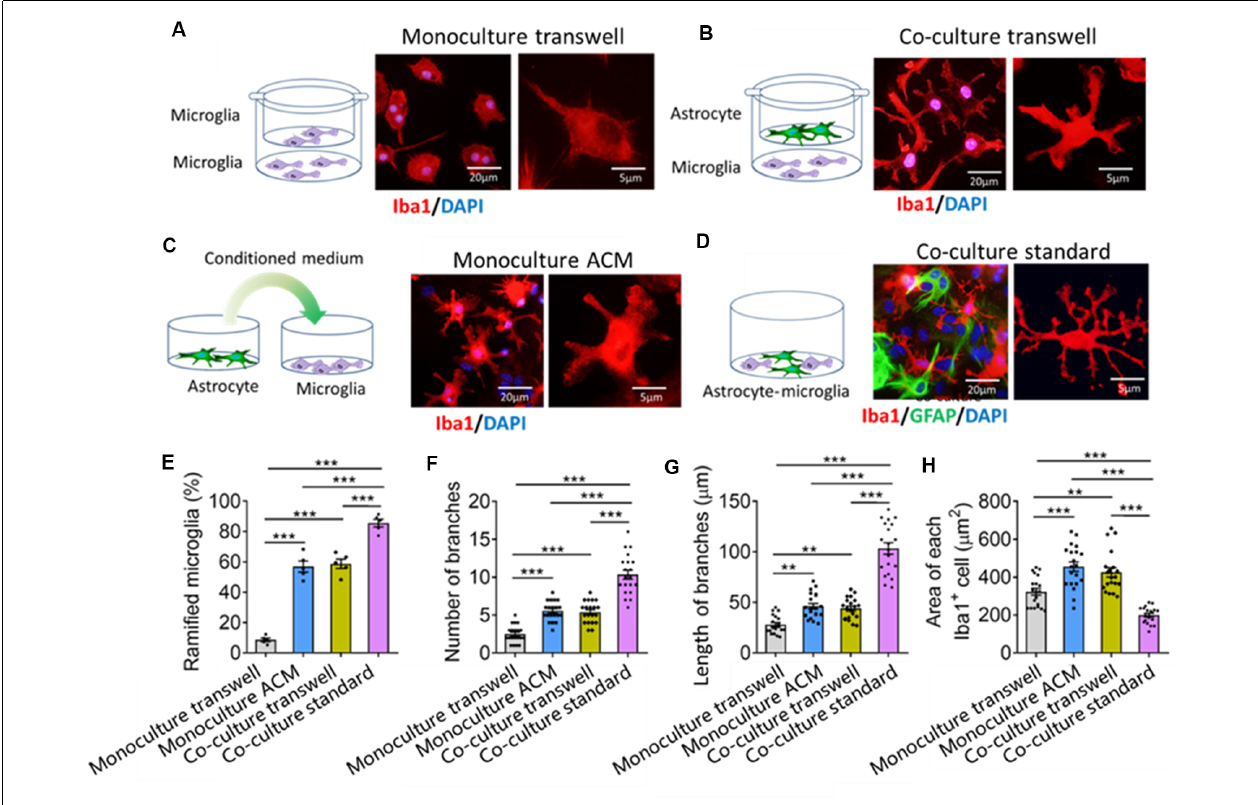
FIGURE 5 | Astrocytes regulate microglial ramification through contact-dependent and -independent mechanisms. (A–D) Schematic diagrams showing four methods of culturing primary microglia: cultured alone (A) , cocultured with astrocyte by transwell (B) , cultured by astrocyte conditioned medium (ACM, C ), and mix cultured with astrocyte (D) . Fluorescence micrographs showing different morphologies of microglia under different conditions. Microglia were labeled by Iba1 (red), astrocytes by GFAP (green), and nuclei by DAPI (blue). (E–G) Percentage of ramified microglia (E) , number (F) and length (G) of branches, and cell body area of microglia (H) . Results of each group were obtained from four independent samples, and 5–6 micrographs were collected from each sample. All Iba1 + cells in each micrograph were measured. Each dot in the bar graph represents the average of all Iba1 + cells in a micrograph. Data are presented as mean ± SEM ( n = 20–24). ** P < 0.01 and *** P < 0.005 between groups (one-way ANOVA with